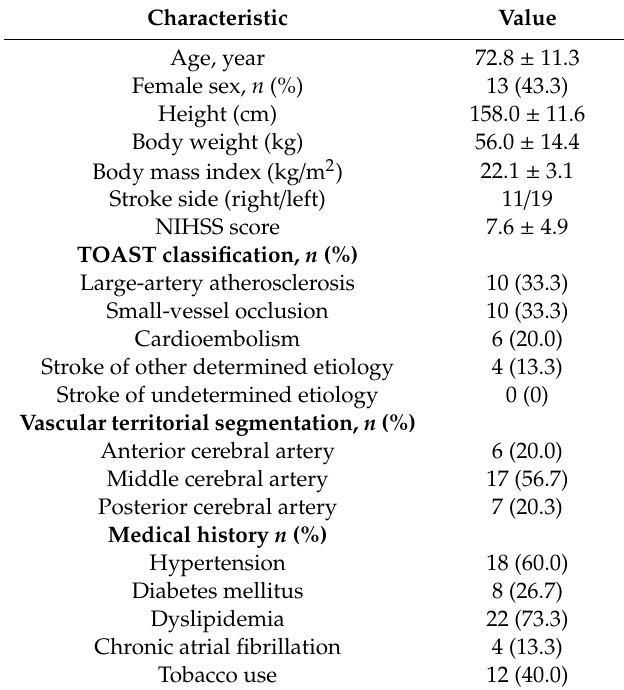
Table 1. Patients’